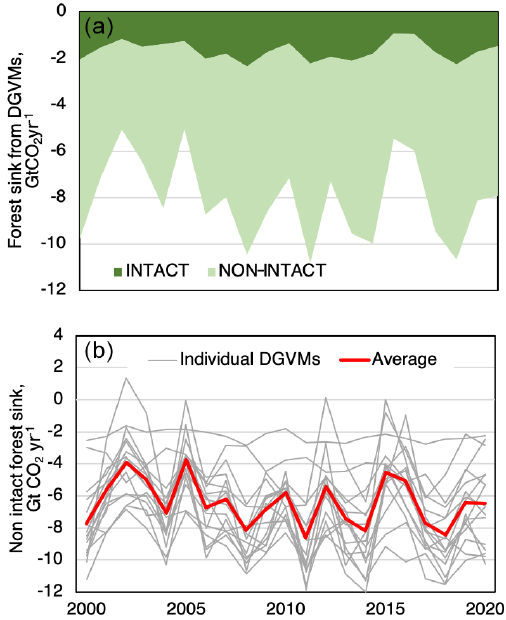
Figure 5. CO 2 fluxes due to environmental change (indirect human-induced and natural effects) for intact and non-intact forests from 2000 to 2020 (panel a , average of 16 DGVMs) and for non- intact forest only ( b , average, and values of individual DGVMs). The DGVM simulations used here are the ones performed for the Global Carbon Budget 2022 (Friedlingstein et al.,